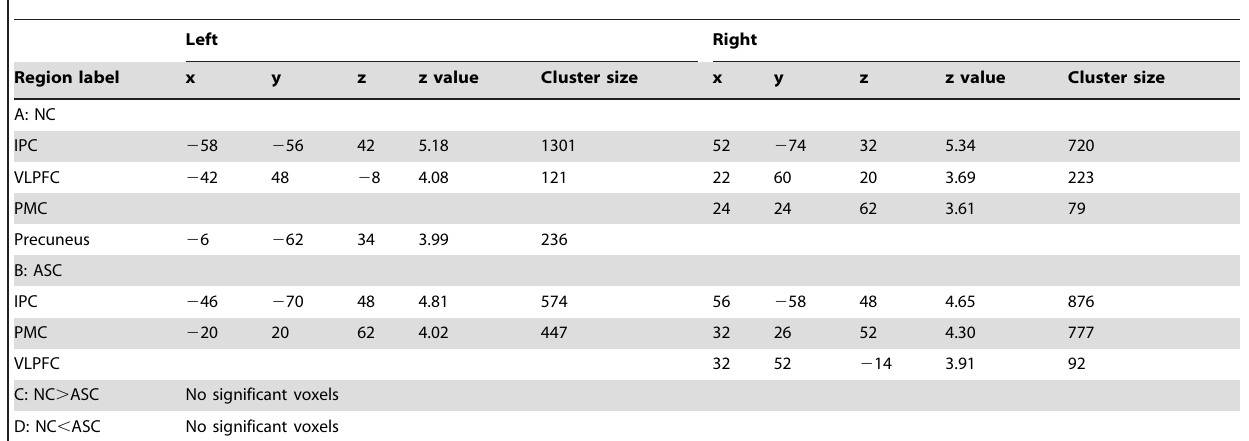
Table 4. Significant activity during difficult analytic